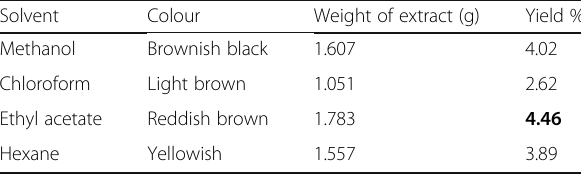
Table 1 Extraction yield (%) of C. epigaeus